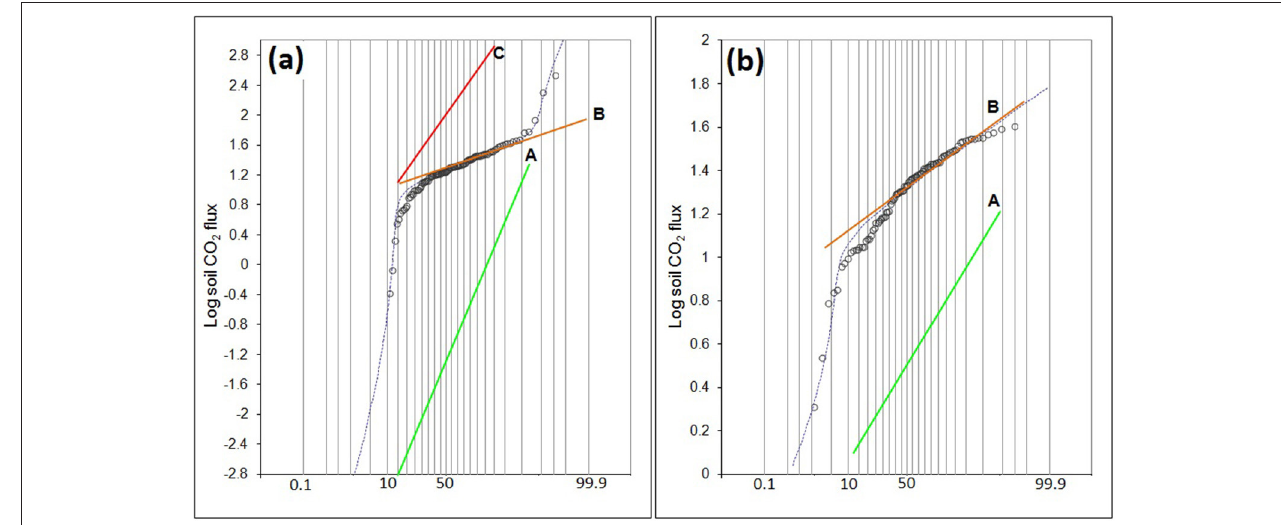
FIGURE 10 | Probability plots of soil CO 2 fluxes measured at Faial (A) and Pico (B) islands. Green, orange and red lines represent populations A, B, and C, respectively.